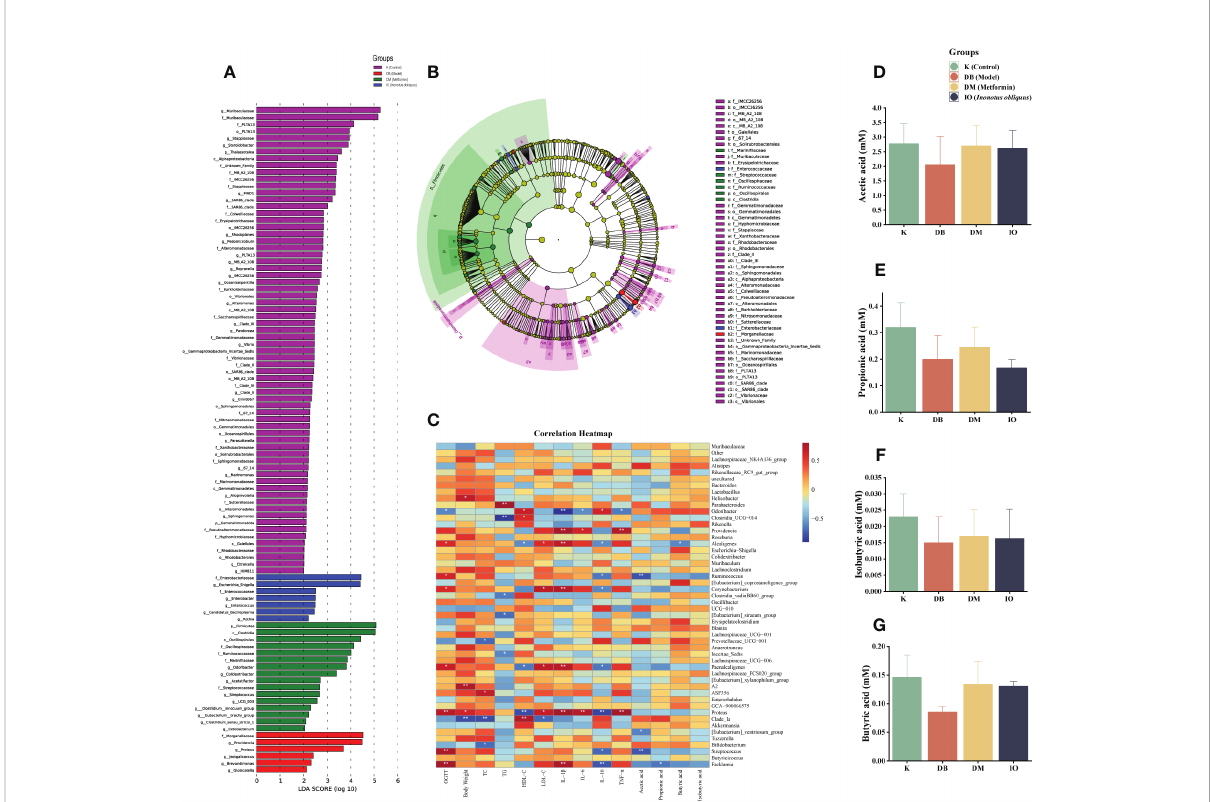
FIGURE 6 LEfSe, SCFAs leves, and correlation analysis. (A) Levels LEfSe analyzed gut microbiota that differed signi fi cantly among groups. Histogram of LDA scores of fecal 16S rRNA sequences from phylum level to genus level with LDA score >3; (B) The inner-to-outer radiating circle represents the evolutionary cladogram from phylum to genus; (C) Heat map of the relationship between intestinal microbiota at species level and diabetes- related indexes (The blue and red represent negative and positive correlation, respectively. * p < 0.05; ** p < 0.01); Inonotus obliquus and metformin can change the composition of short chain fatty acids (SCFAs) in the stool of mice. Inonotus obliquus and metformin could restore fecal short-chain fatty acid content in db/db mice. Inonotus obliquus alters fecal short-chain fatty acids (SCFAs) levels of (D) acetate acid, (E) propionate acid, (F) butyrate acid and (G) isobutyrate